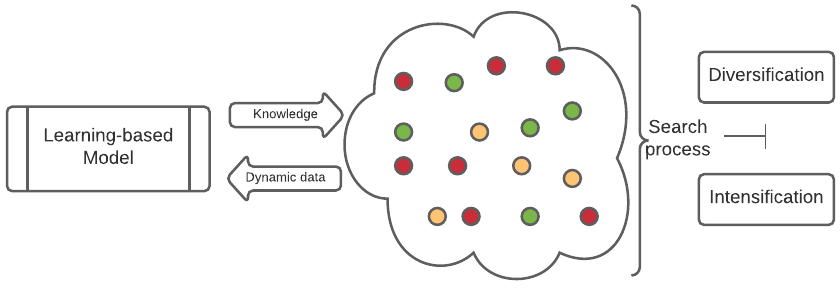
Figure 2. Graphic example of the search